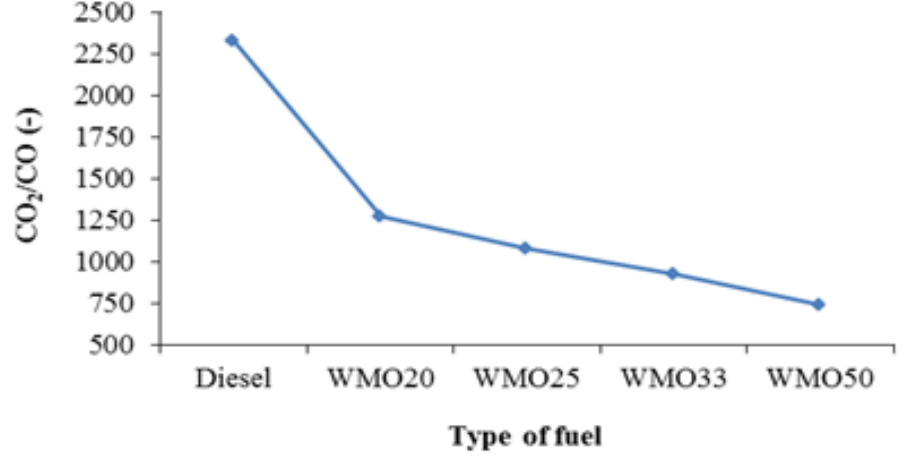
Figure 6. The ratio of emissions CO 2 /CO for different types of fuels.